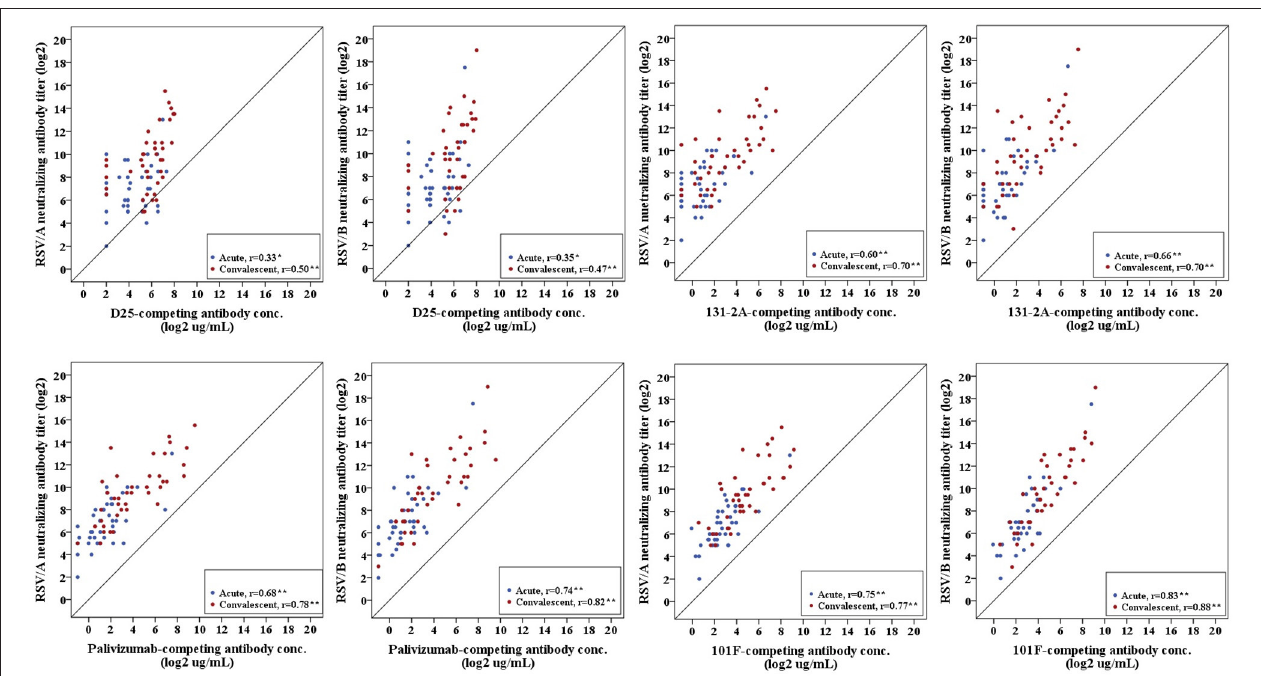
FIGURE 5 | Correlation of RSV antigenic site-specific competitive antibody and RSV-specific neutralizing antibody. Pearson’s correlation coefficient was calculated to measure the strength of the linear association. Correlation coefficients ranged from 0.33 to 0.83 for acute sera, and 0.50–0.88 for convalescent sera. *Correlation is significant at the 0.05 level (2-tailed). **Correlation is significant at the 0.01 level (2-tailed). n = 40 in each competitive antibody assay and microneutralization assay.